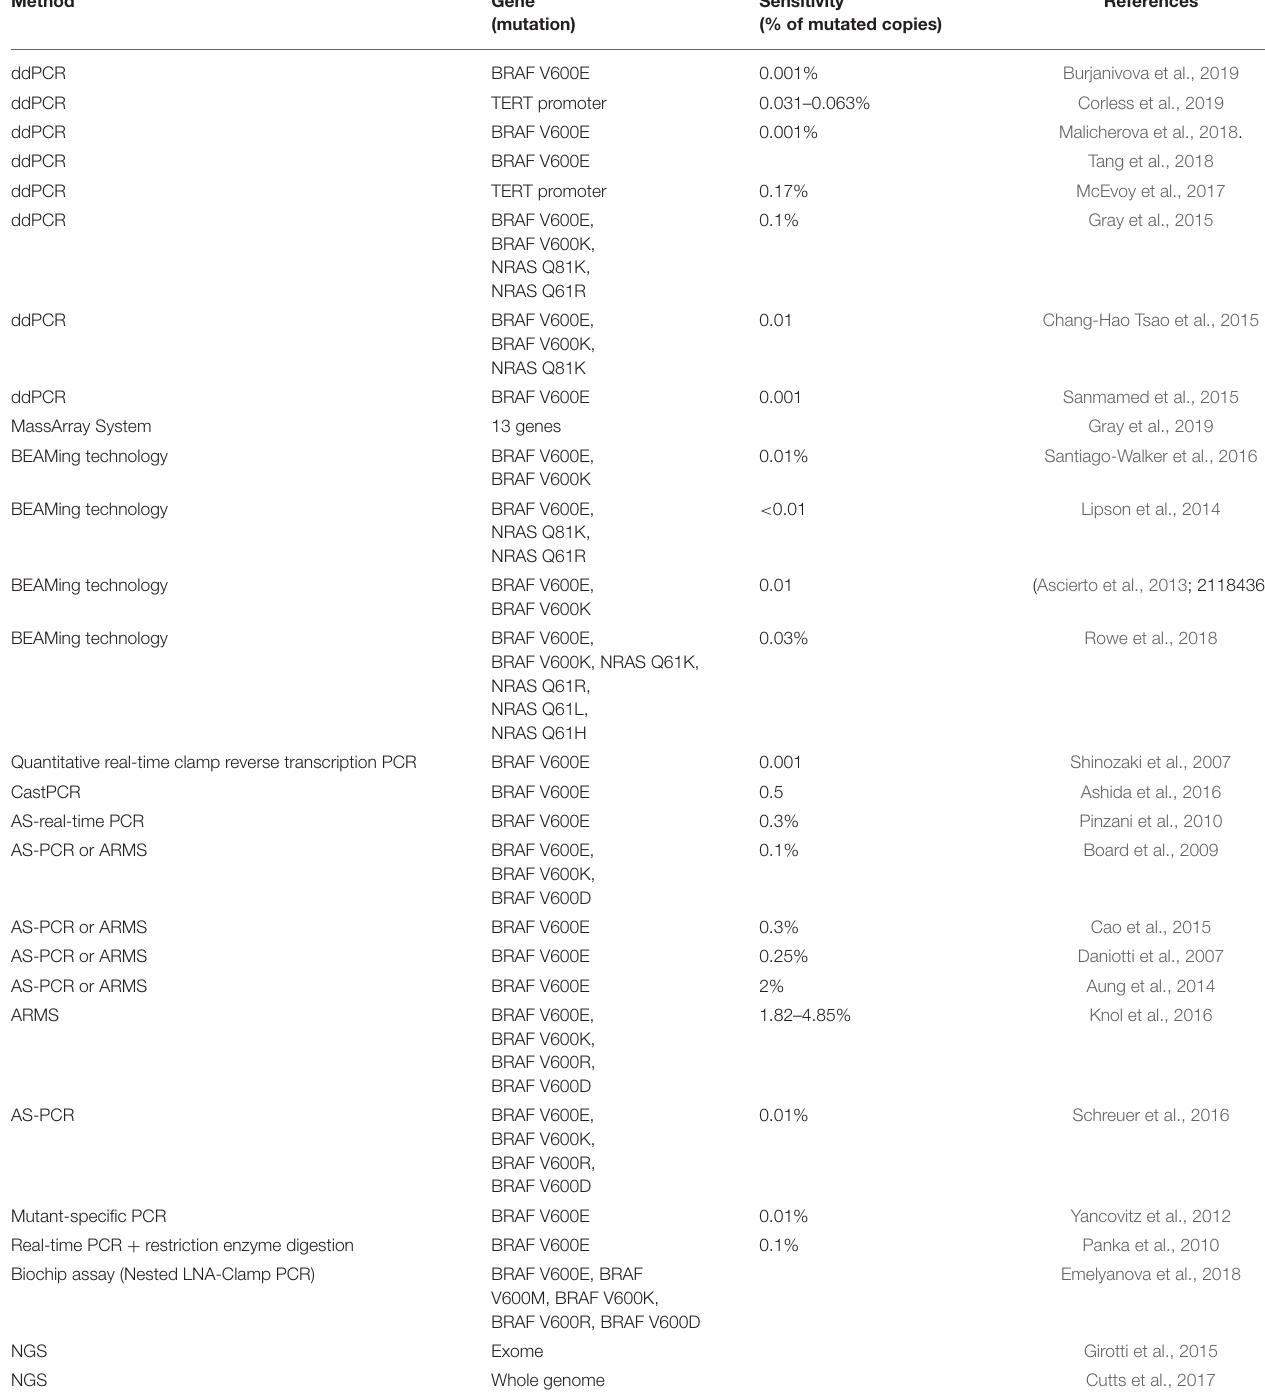
TABLE 2 | Overview of techniques used for the detection of BRAF mutation in cfDNA from melanoma